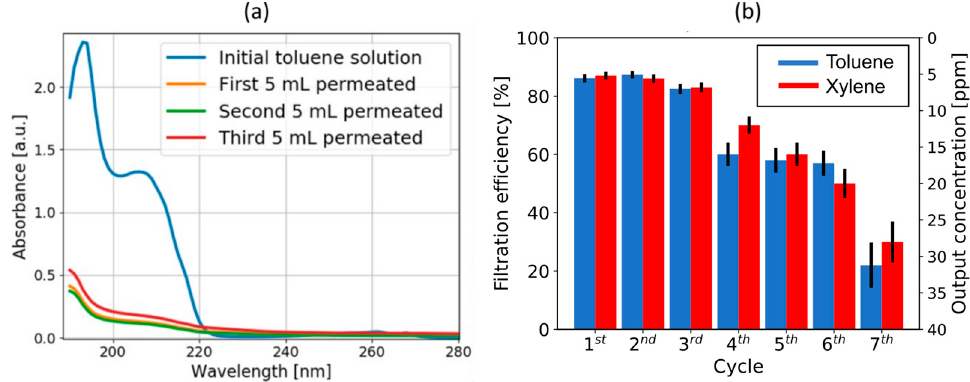
Figure 7. ( a ) UV-Vis spectra of feed toluene solution and solutions after filtration. ( b ) Filtration efficiency of PVA-UVCNP during a dead-end filtration experiment with initial toluene/xylene concentration of 40 mg/L and solution feed of 10 L h − 1 m − 2